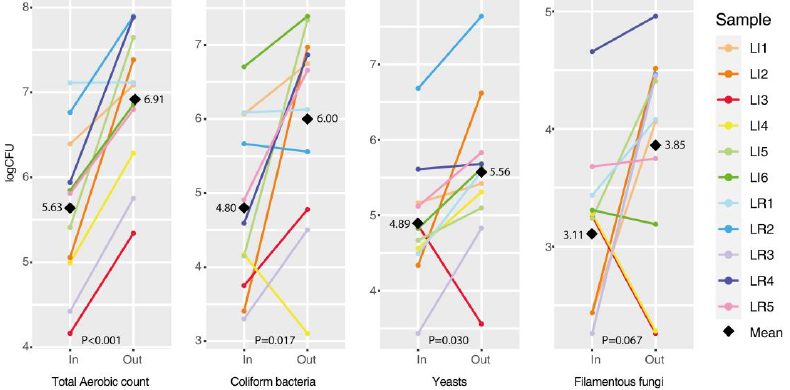
Figure 7. Comparison of microbial counts of log10 (CFU.g −1 ) in inner (In) and outer (Out) leaves of rosette-forming lettuces. p -values are based on pair t-test. Table 2. Alpha diversity indices of microbial communities in samples of inner and outer lettuce leaves as compared by paired t-test.